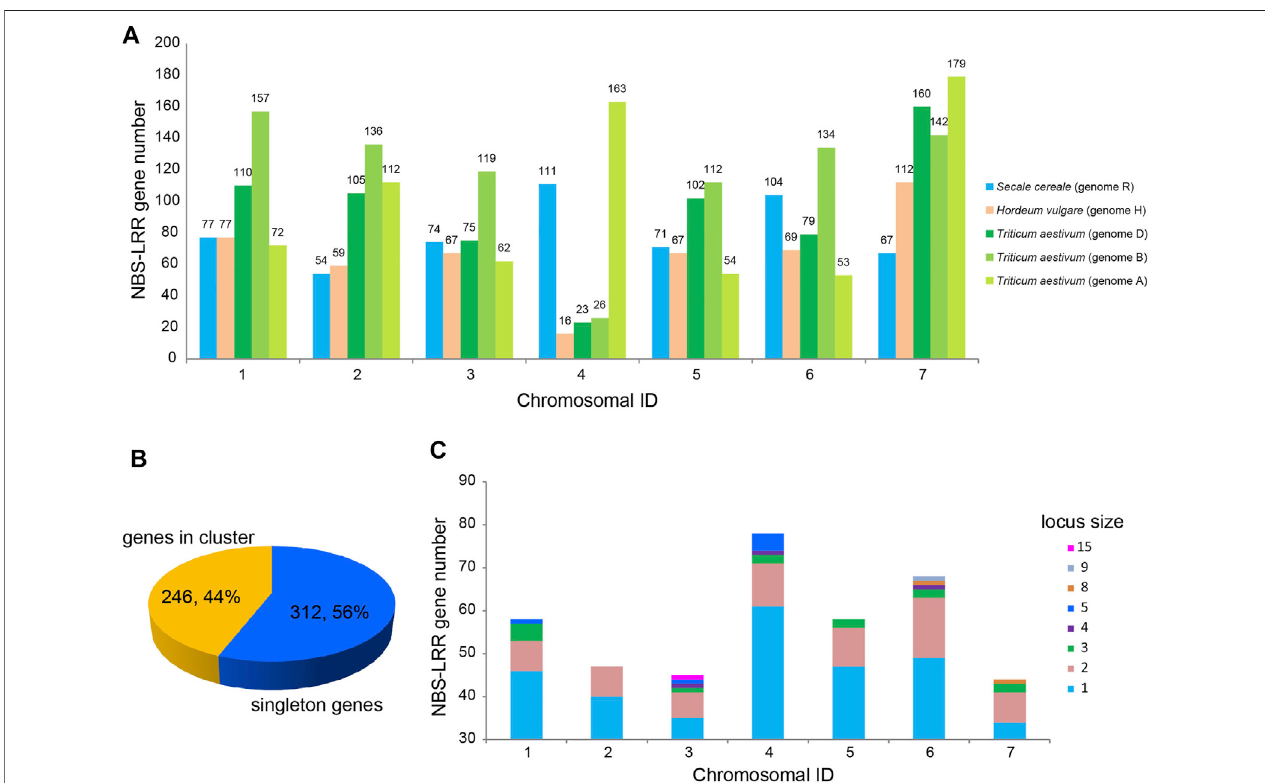
FIGURE2 | Chromosomal distribution ofNBS-LRRgenes in S. cereale . (A) Comparative analysisofchromosomal distribution ofNBS-LRRgenesin S.cereale , H. vulgare and T. aestivum . (B) Proportion of NBS-LRR genes appearing as singletons (blue) and clusters (yellow) in the S. cereale genome. (C) Proportion of NBS-LRR genes appearing as singletons or different-size clusters on each chromosome of S.